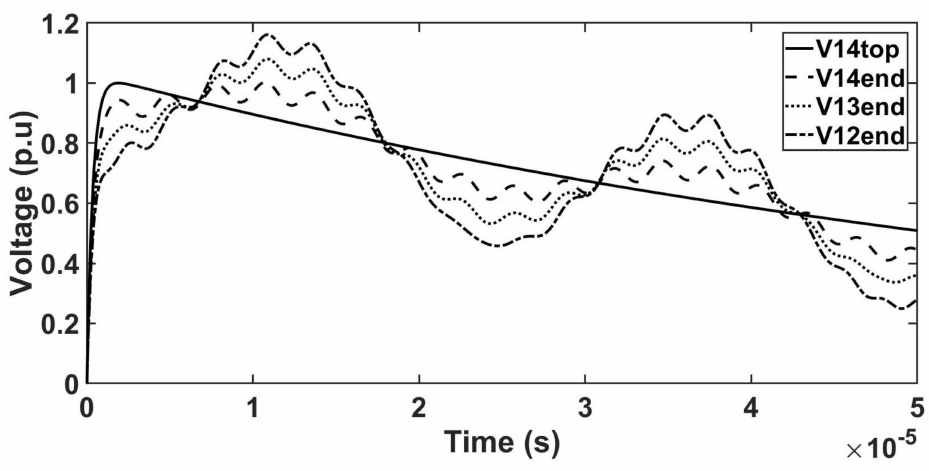
Figure 15. Surge voltage waveforms for unshielded winding under SLI.